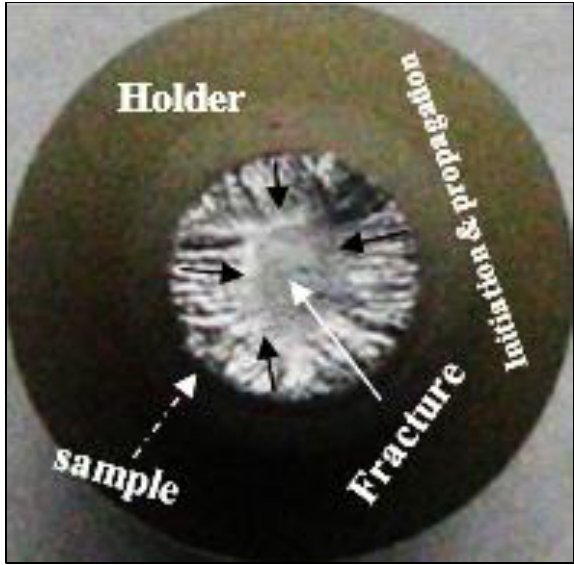
Figure 19. Fracture of fatigue-tested samples in the present work.